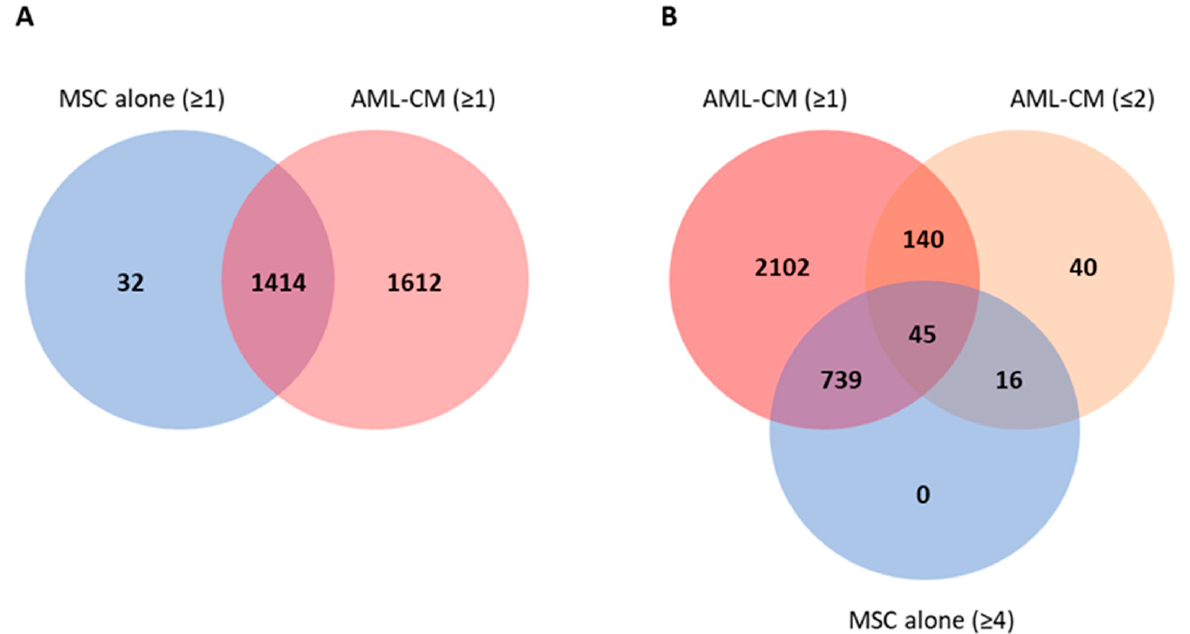
Figure 3. Venn diagrams of proteins quantified in MSC and AML-conditioned media samples. ( A ) Number of proteins quantified in at least one AML/MSC sample. ( B ) Number of proteins quantified in one or more AML-CM sample compared to the number of proteins quantified at least four MSC replicates (cultured alone) and in two or fewer AML-CM samples. In total, 61 proteins (45 + 16) were more often released by the MSCs as they were found in only two or fewer AML-CM samples. Table 2. GO analysis of all gene/protein names identified in this study, i.e., all proteins identified for the MSCs cultured alone, 40 primary AML cells cultured alone (AML-CM) and/or MSCs cultured in the presence of AML-conditioned medium (MSC/AML-CM). The presentation is based on a bioinformatical analysis of GO terms/cellular compartment, and the list presents all terms that included at least 100 of the identified proteins (hypergeometric test, Bonferroni correction). The data are presented as the number of proteins associated to a given term, number of proteins in the background dataset, percent of proteins in the dataset annotated to a given GO term, the fold enrichment and the p -values. Proteins in the Number of Percent of Cellular Compartment Background Proteins Dataset